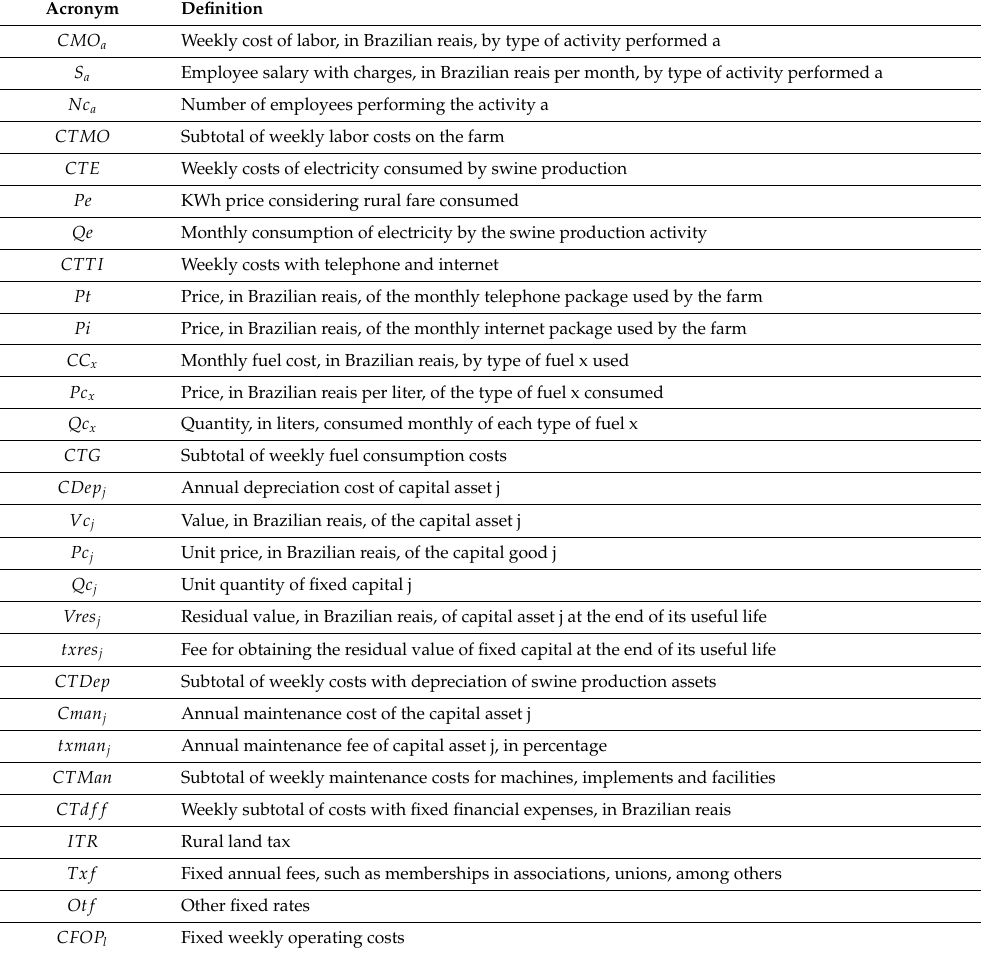
Table 5. Acronyms and definitions of formulas used to calculate the fixed operating costs that compose the calculation model for swine